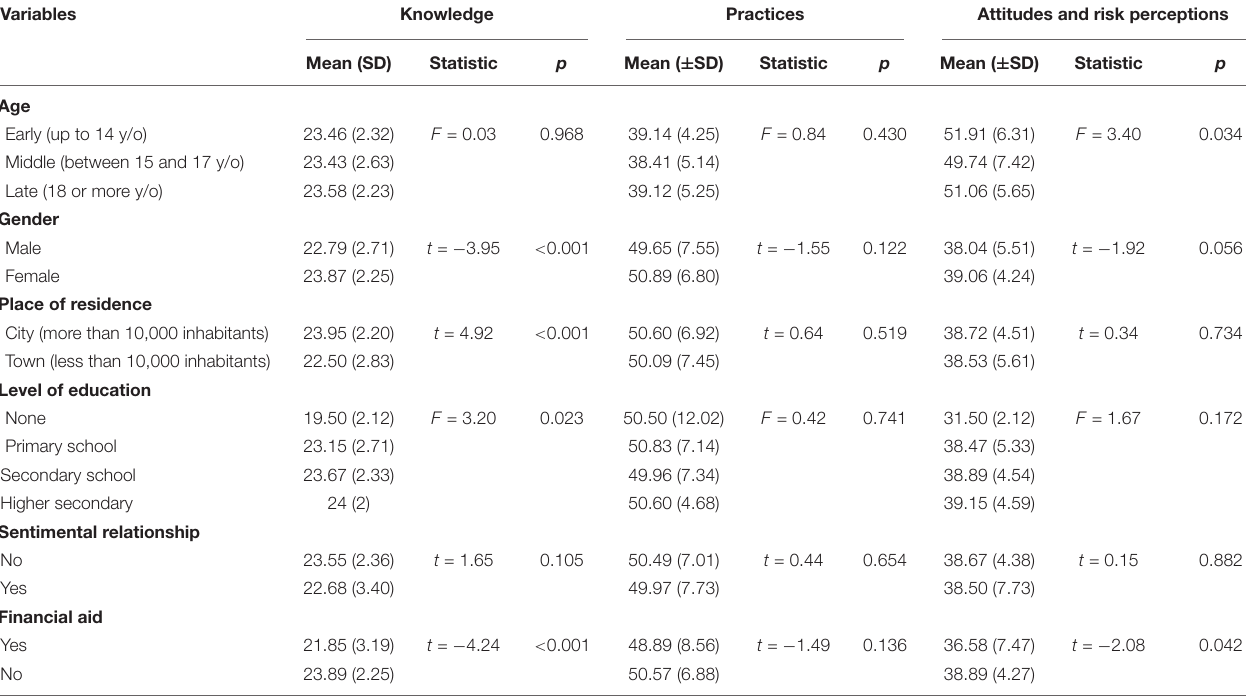
t-Test for categories with two variables and analysis of variance (ANOVA) for the rest of the categories.